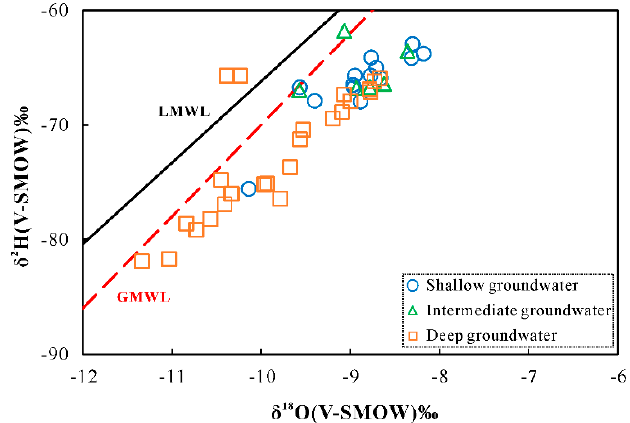
Figure 3. Stable isotopes δ 18 O vs. δ D plot of the groundwater samples from the Yuncheng Basin, compared with the global meteoric water line (GMWL: δ 2 H = 8 δ 18 O + 10 [35,36]) and local meteoric water line derived from the weighted mean monthly rainfall stable isotope values at Xi’an, 150 km Southwest of Yongji City (LMWL: δ 2 H = 7.1 δ 18 O + 4.87 [37]).